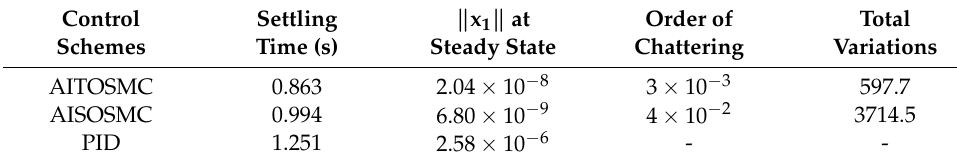
Table 4. Comparative performance measures of three control